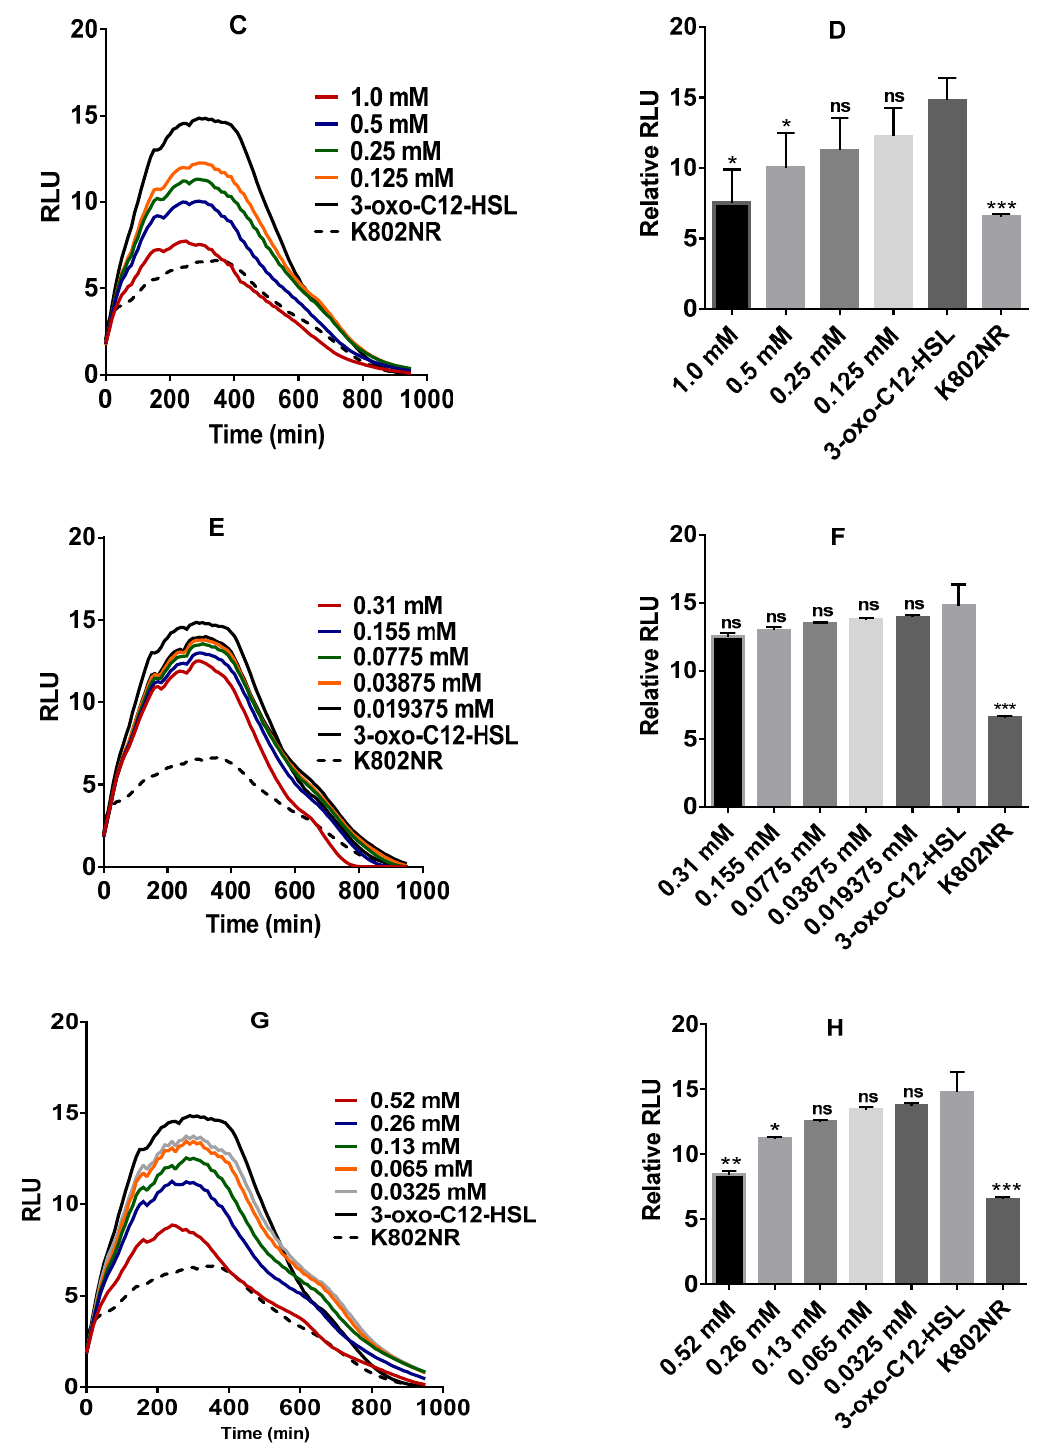
Figure 3. The bioluminescent response of K802NR reporter strain in the presence of pure stevia-derived components. ( A ) Stevia extract; ( B ) stevia extract relative to the control, corresponding to the data in panel A; ( C ) stevioside; ( D ) stevioside relative to the control, corresponding to the data in panel C; ( E ) Reb A; ( F ) Reb A relative to the control, corresponding to the data in panel E ( G ); steviol; ( H ) steviol relative to control, corresponding to the data in panel G. Error bars are not shown in A, C, E, and G to ensure clarity of figures. The final concentration of 3-oxo-C 12 -HSL was 5 × 10 − 10 M. All presented concentrations are the final concentrations. The amount of luminescence is expressed in relative light units or RLUs. * p < 0.05, ** p < 0.01, *** p < 0.001, and ns not significant. Values represent mean ± SD, n = 3 (three di ff erent experimental